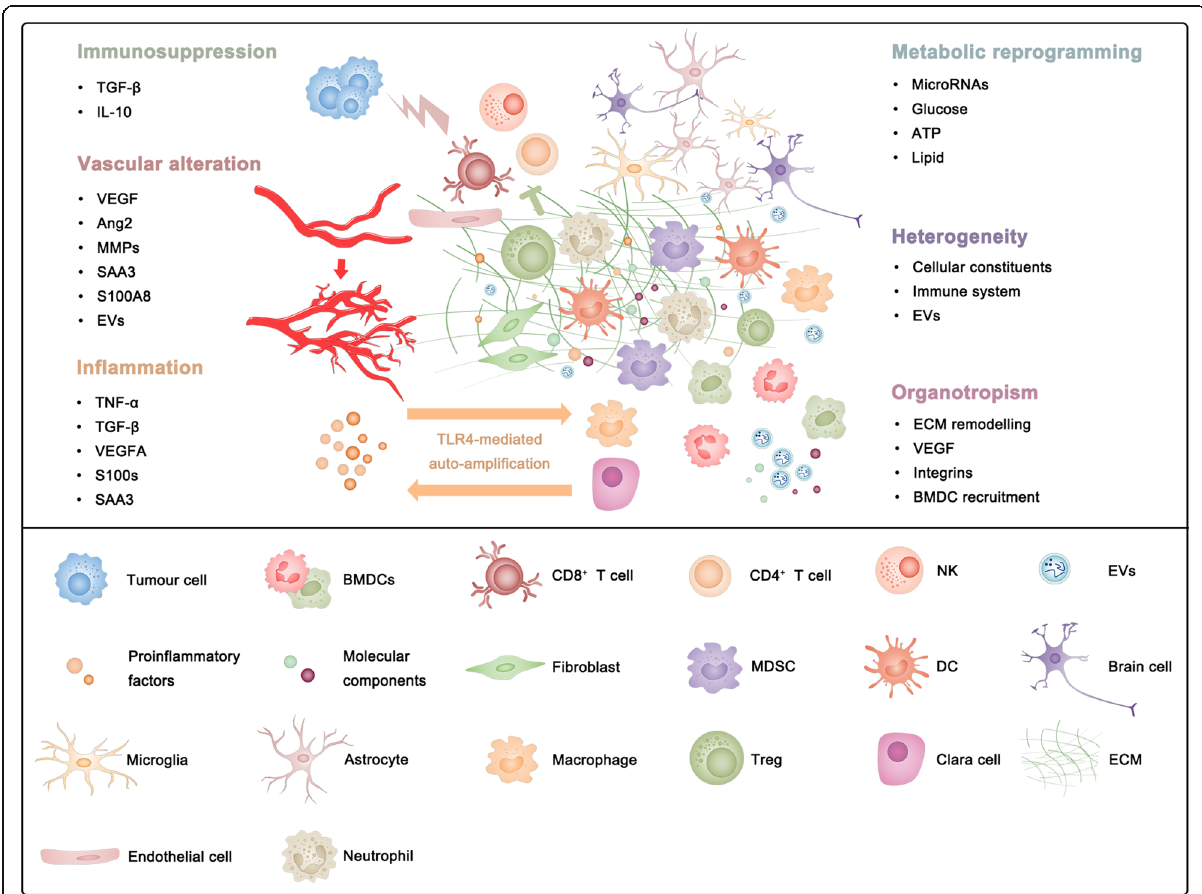
Fig. 1 The main characteristics of the pre-metastatic niche (PMN) can be recognized as vascular alteration, immunosuppression, inflammation, metabolic reprogramming, heterogeneity and